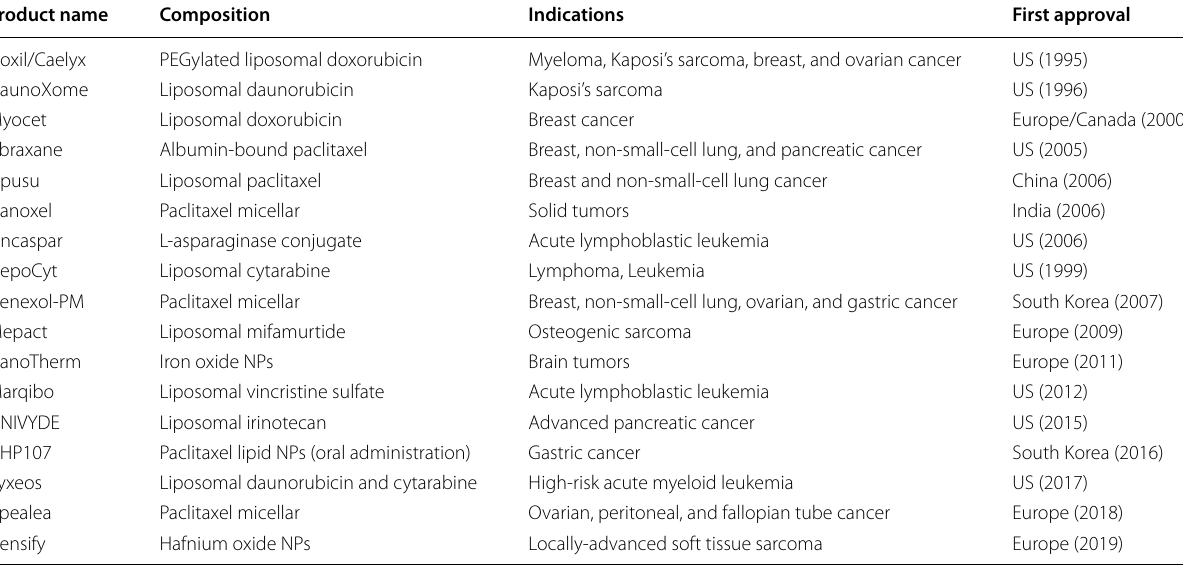
Table 1 Nano-formulated cancer therapeutics currently on market(Adapted with permission